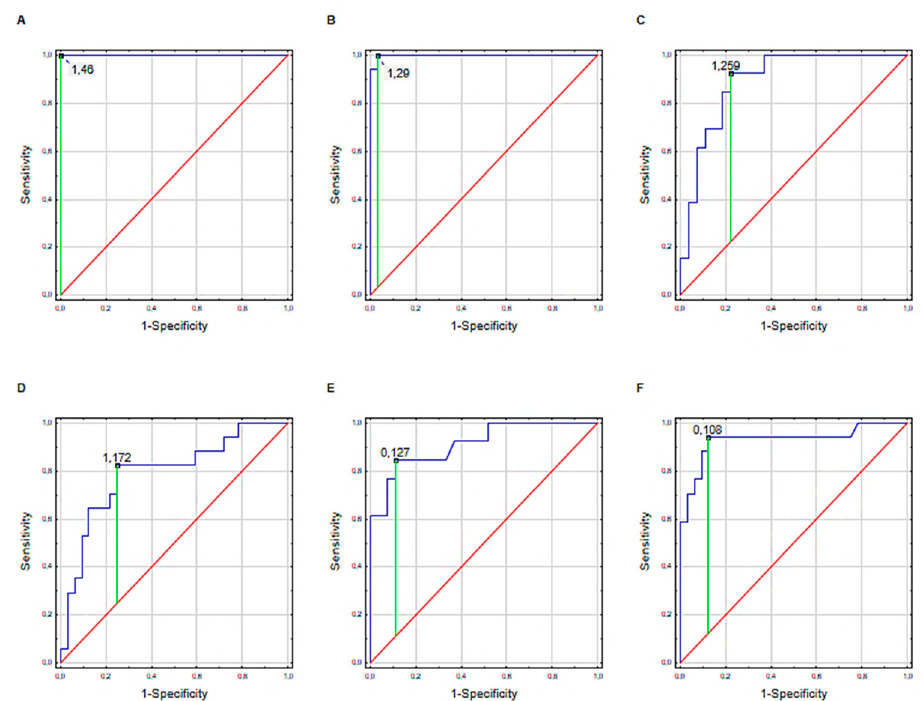
Figure 2. ROC curves analysis for UPIIIa and UPII in selected urological diseases: ( A ) UPIIIa (BPH-plasma), ( B ) UPIIIa (UTI-plasma), ( C ) UPIIIa (BPH-urine), ( D ) UPIIIa (UTI–urine), ( E ) UPII (BPH-urine), ( F ) UPII (UTI-urine). Abbreviations: BPH—benign prostatic hyperplasia; US—urethral stricture; UTI—urinary tract infection.